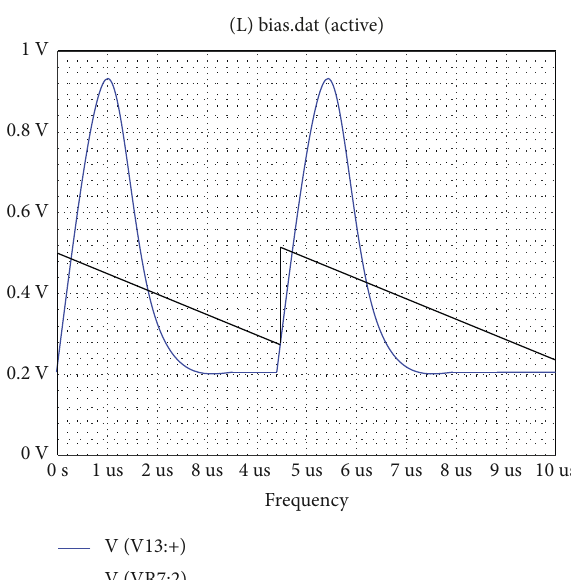
Figure 5: Anti-aliasing filter.